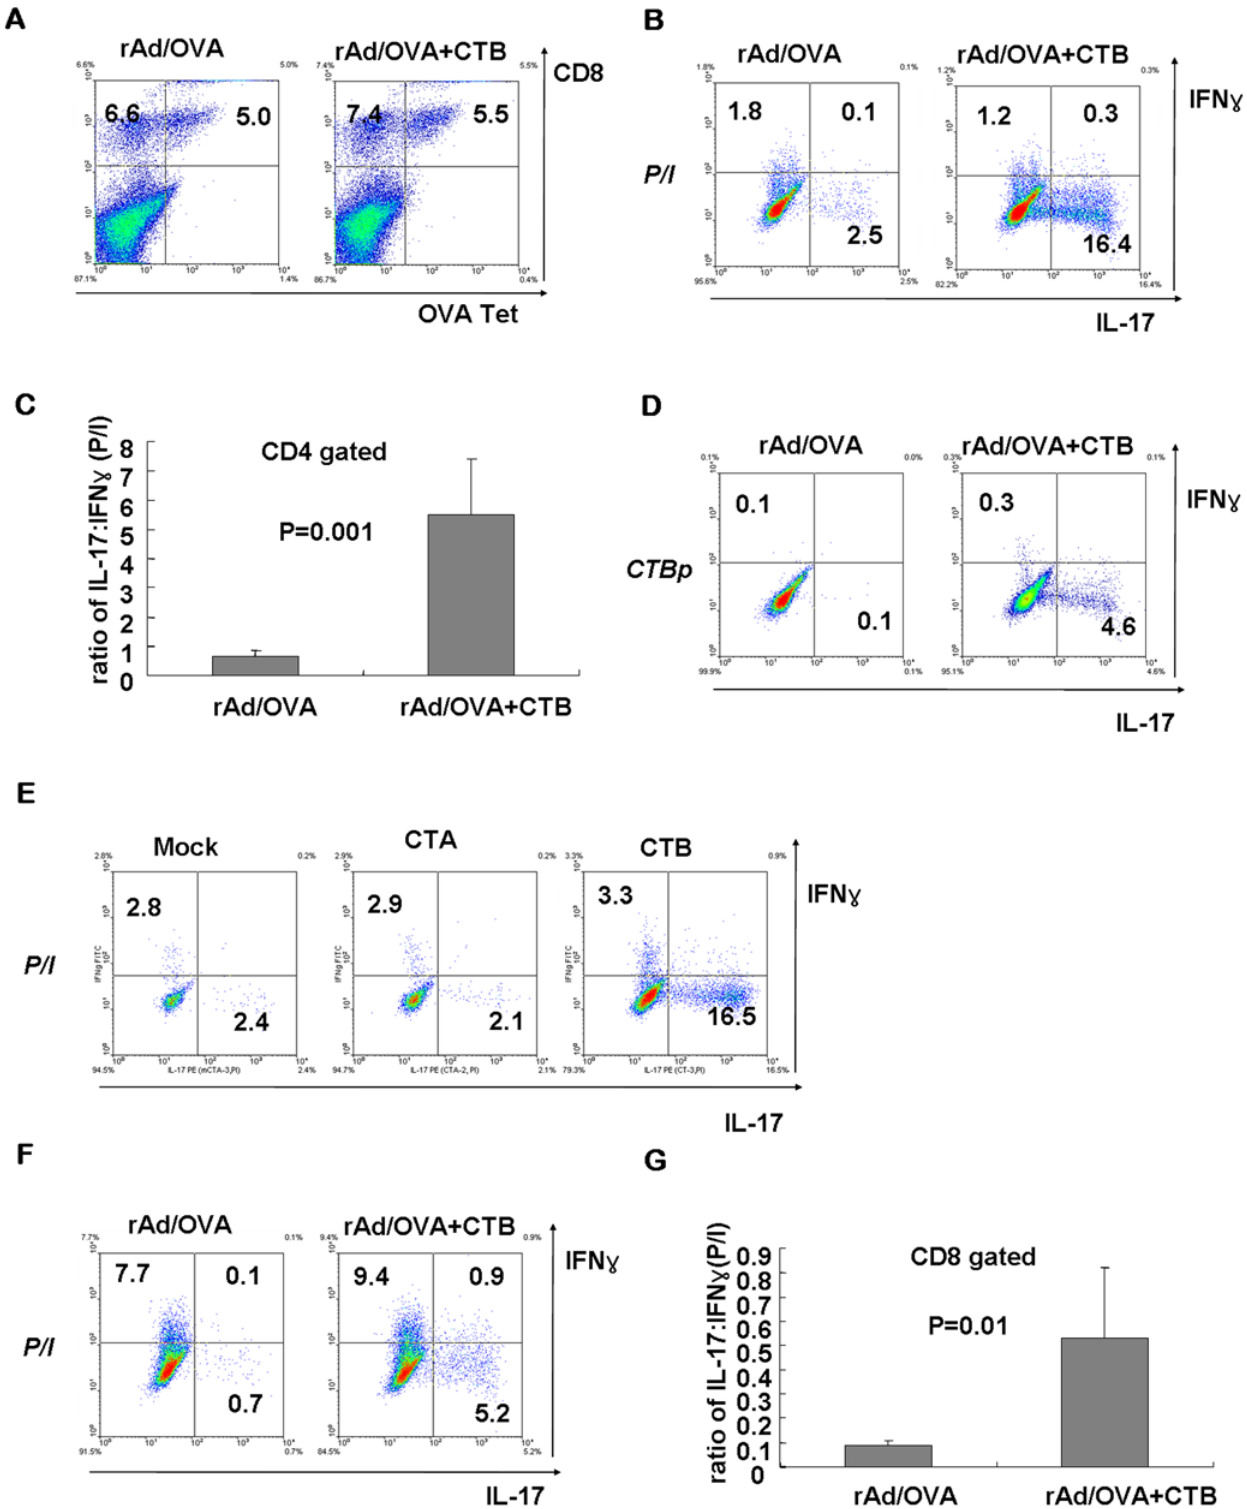
transgenic mice and IL-6KO mice (B6 background) were from the Jackson Laboratory (Bar Harbor, ME). Mice were housed under specific pathogen-free conditions and were used between 5 and 8 weeks of age. All animals were handled in strict accordance with